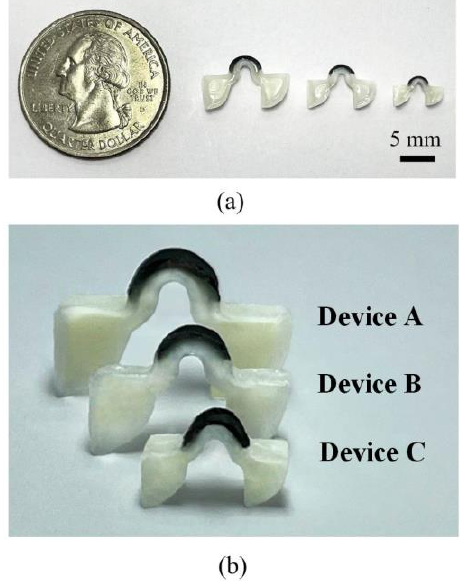
Figure 6. Fabricated LCE devices of different sizes: ( a ) side view of the devices with a scale bar. ( b ) side view of devices at standing position ready for locomotion.